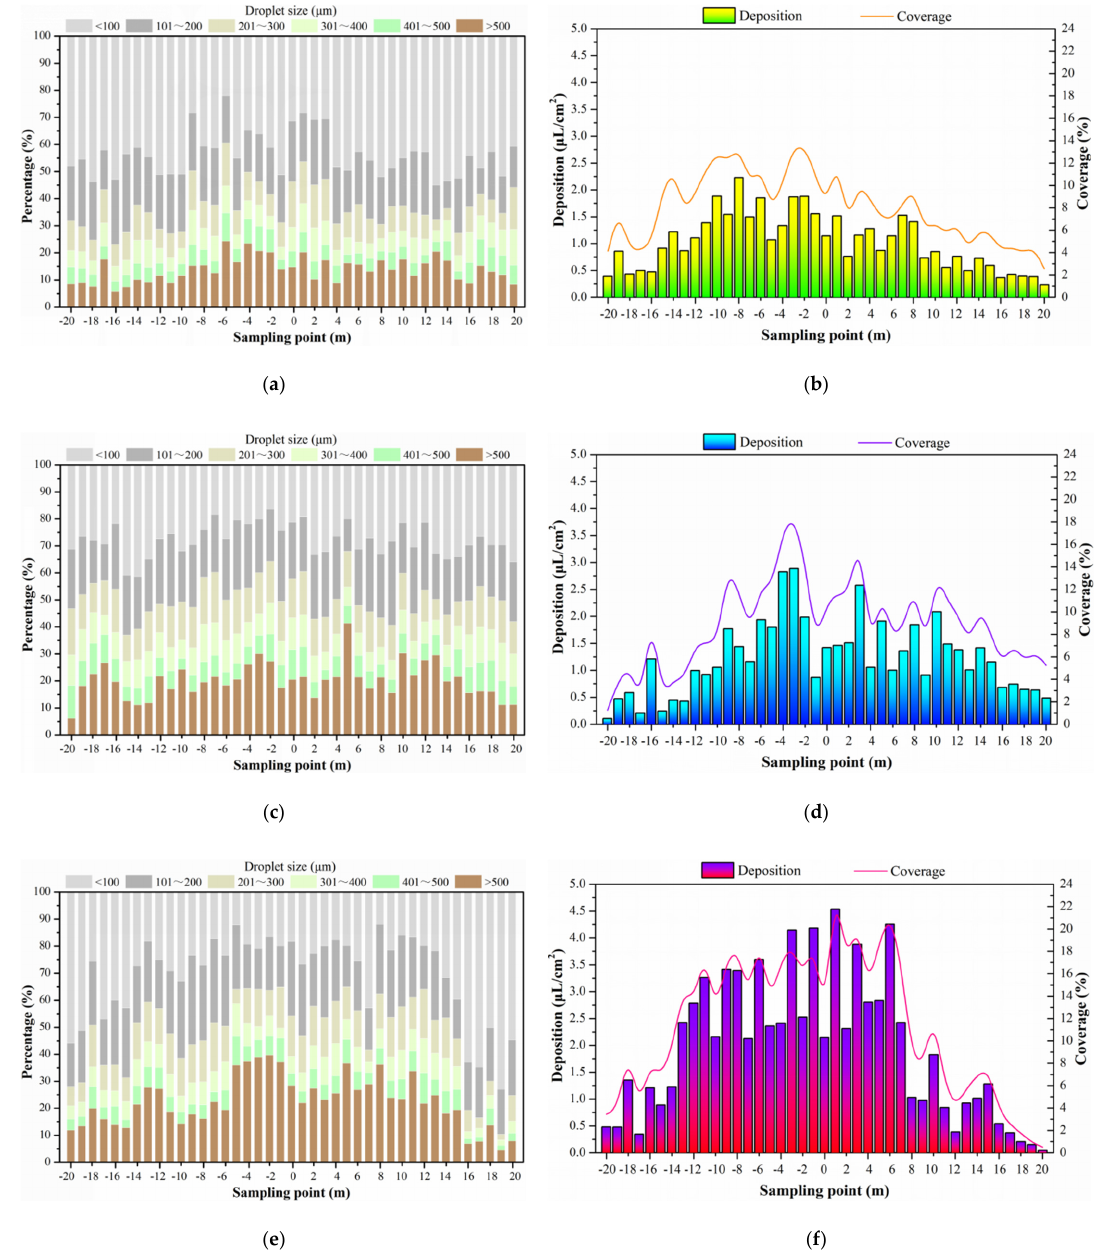
Figure 8. ( a ) Droplet size spectrum percentage of test 1# in the spray area; ( b ) deposition and coverage of test 1# in the spray area; ( c ) droplet size spectrum percentage of test 2# in the spray area; ( d ) deposition and coverage of test 2# in the spray area; ( e ) droplet size spectrum percentage of test 3# in the spray area; ( f ) deposition and coverage of test 3# in the spray area.